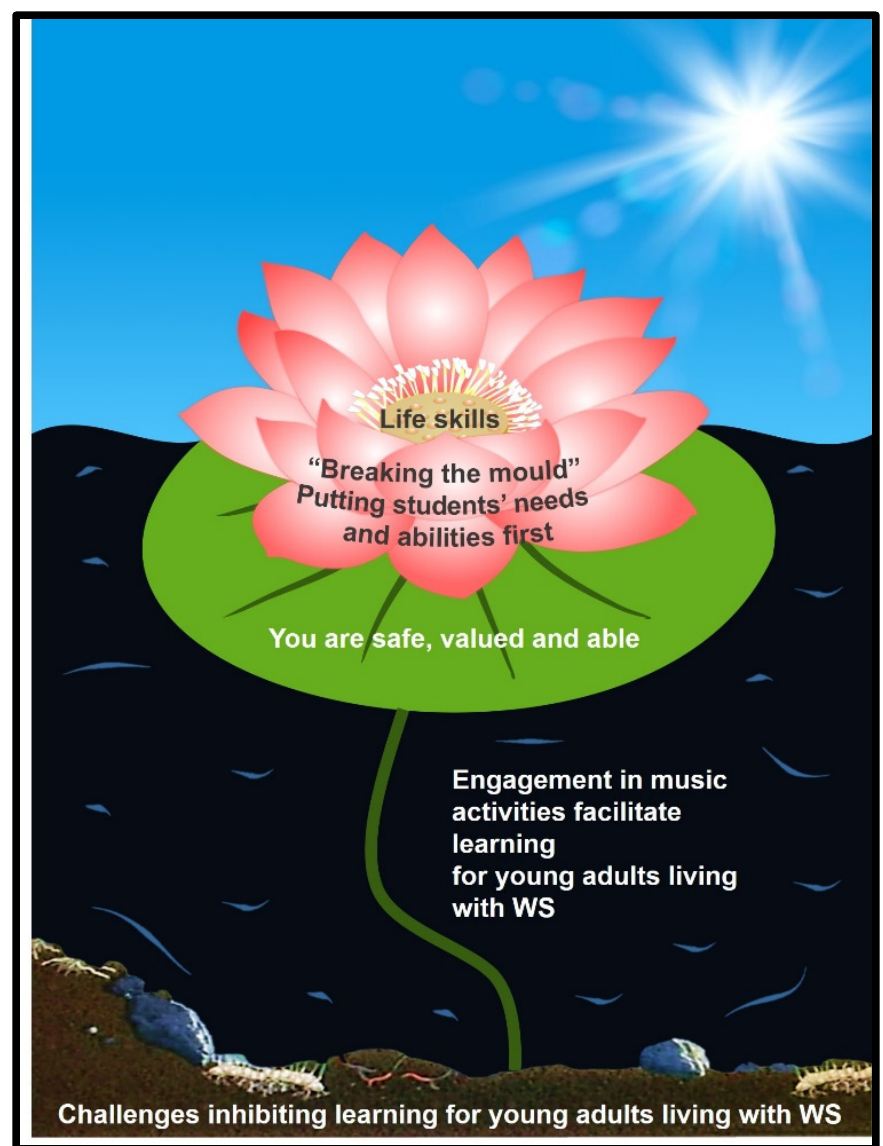
Figure 2. A theory explaining how young adults living with WS learn life skills through